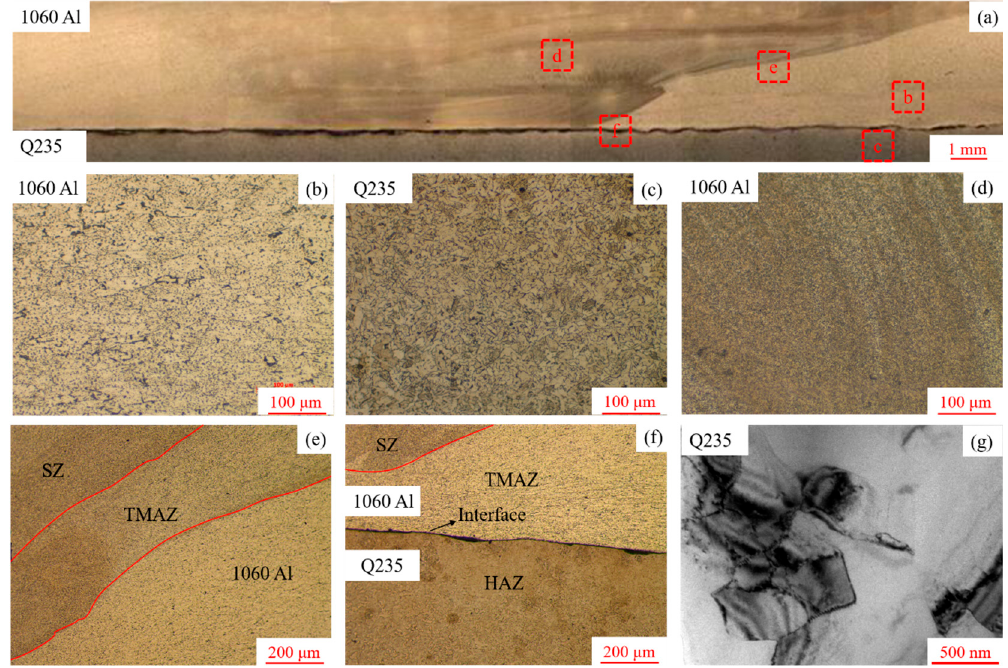
Figure 4. Microstructures of composite plate after friction stir processing (FSP) with different passes: ( a ) repair zone; ( b ) base metal (BM) of aluminum; ( c ) BM of steel; ( d ) stirring zone (SZ); ( e ) thermo-mechanical affected zone (TMAZ) in the aluminum side; ( f ) heat affected zone (HAZ) in the steel side and ( g ) transmission electron microscopy (TEM) image near the interface.